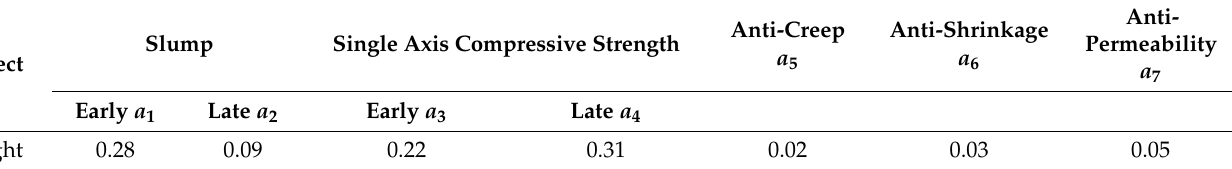
Table 8. Evaluation